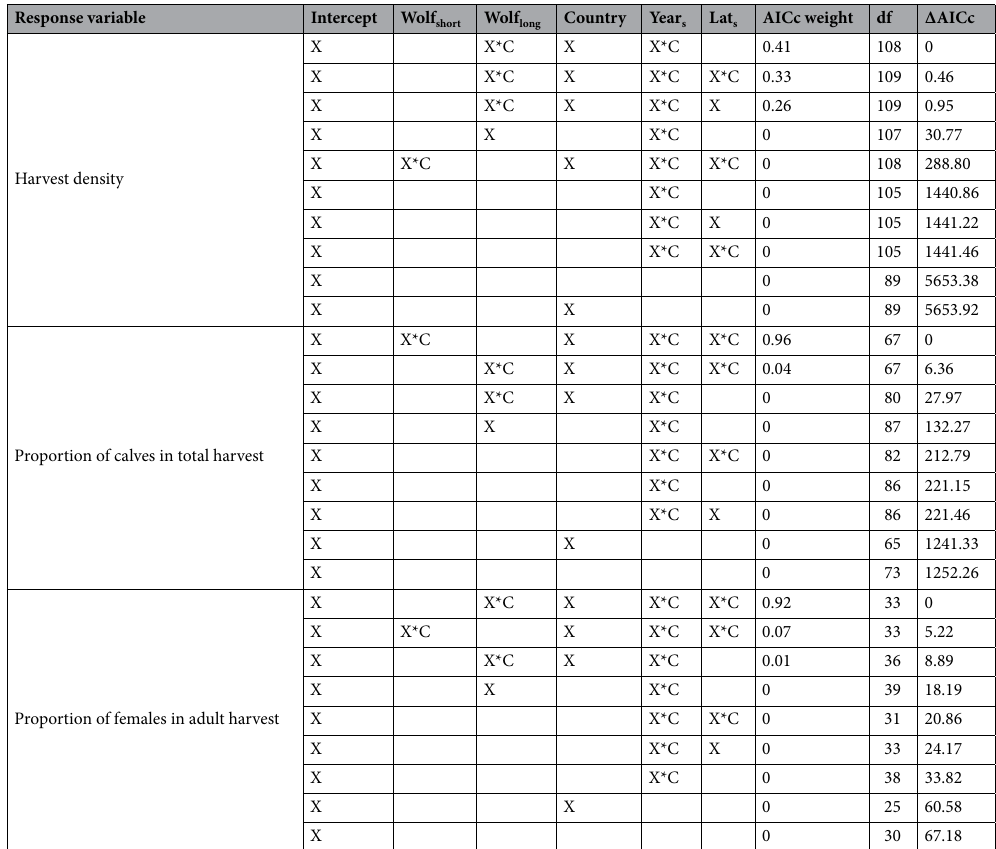
Table 1. Generalized additive mixed models (GAMM) assessing the effect of short- and long-term wolf index (Wolf short or Wolf long ) as linear functions, year (Year s ) and latitude (Lat s ) as smooth functions, and country (Norway, Sweden) on harvest density of moose (per km 2 ), proportion of calves in total harvest, and proportion of females in adult harvest in Sweden and Norway during 1995–2017. X*C indicates that the specific variable was included in the model as an interaction with country. The management unit ID was included in all models as a smooth random variable. For each model, AICc weights, degrees of freedom (df), and difference in AICc relative to the highest-ranked model (ΔAICc) are